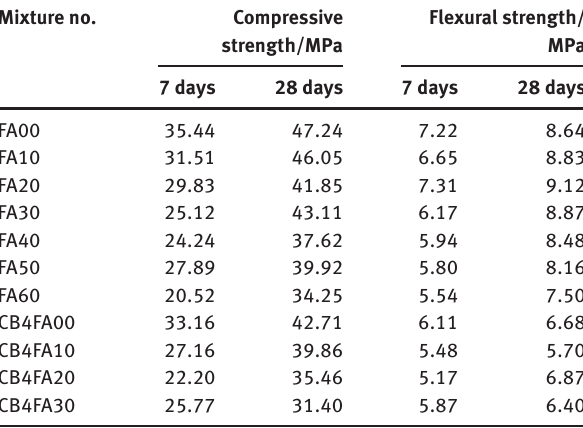
Table 6: Compressive strength and flexural strength of samples containing different replacement levels of FA. Mixture no.